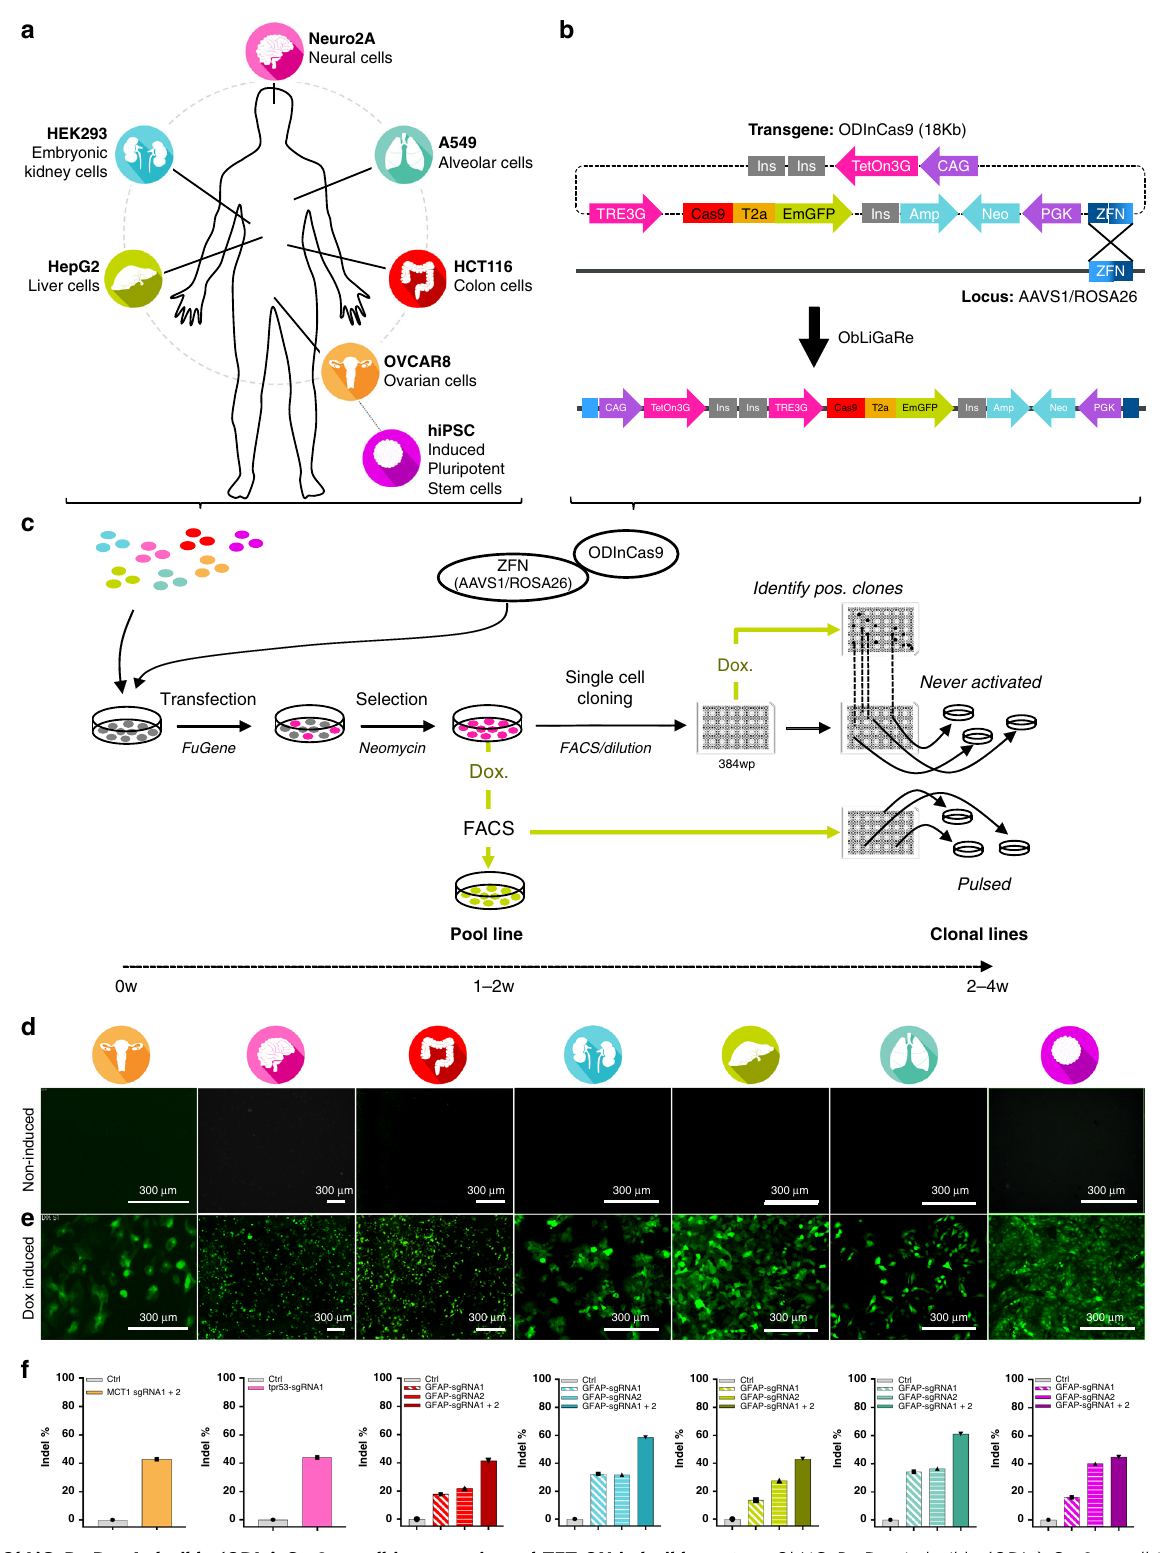
Fig. 1 ObLiGaRe Dox Inducible (ODIn) Cas9, an all in one, universal TET ON inducible system. ObLiGaRe Dox-inducible (ODIn) Cas9, an all-in-one, universal Tet-On inducible system a human and mouse cell lines sourced from brain (N2A), lung (A549), colon (HCT116), ovarian tissue (OVCAR8), liver (HepG2), kidney (HEK293), and human-induced pluripotent stem cells (iPSC) engineered using b the ODInCas9 system targeting the AAVS1 or ROSA26 locus using ZFN-directed ObLiGaRe. c Outlined methodology for rapid cell line generation of ODInCas9 pools and clonal lines encountered with or without exposure to Cas9. Evaluation of GFP expression of d non-induced and e Doxycycline Inducible ODInCas9 cell lines. f Quanti fi cation of mismatch endonuclease assay estimating indel formation post sgRNAs transfection of induced ODInCas9 cell lines targeting; MCT1 in OVCAR8, Tpr53 in N2a, and GFAP in HCT116, HEK293, HepG2, A549, and iPSC ( n = 7 biological independent cell lines). Scale bar: 300 μ